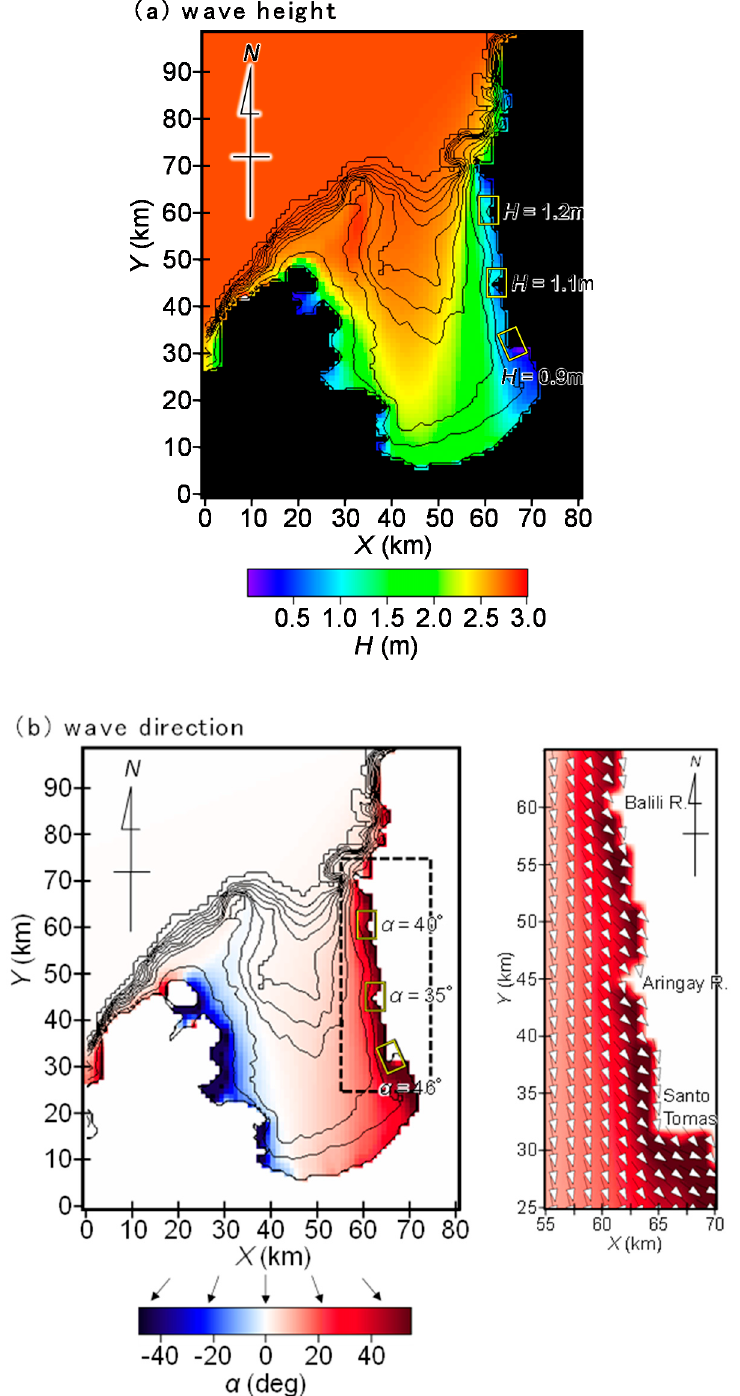
Figure 26. Predicted wave height and wave direction in Lingayen Gulf ( S max = 75), ( a ) wave height, ( b ) waive direction.